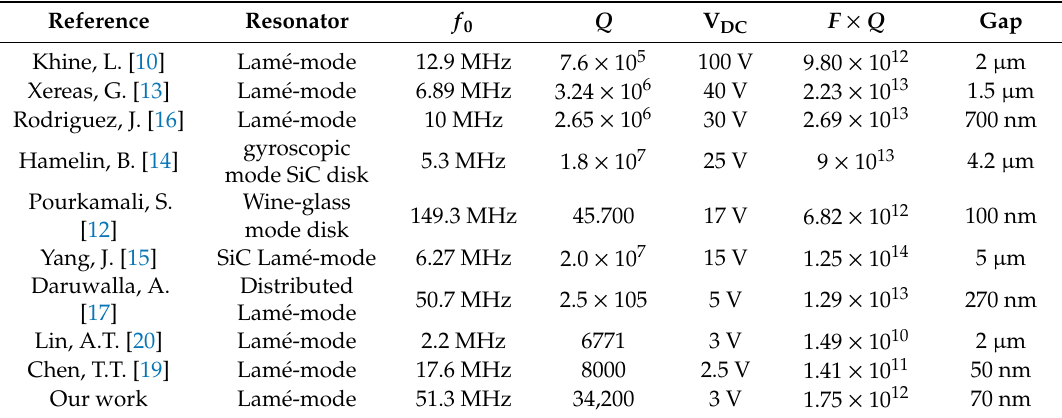
Table 1. Comparison between state-of-the-art works and our Lam é mode